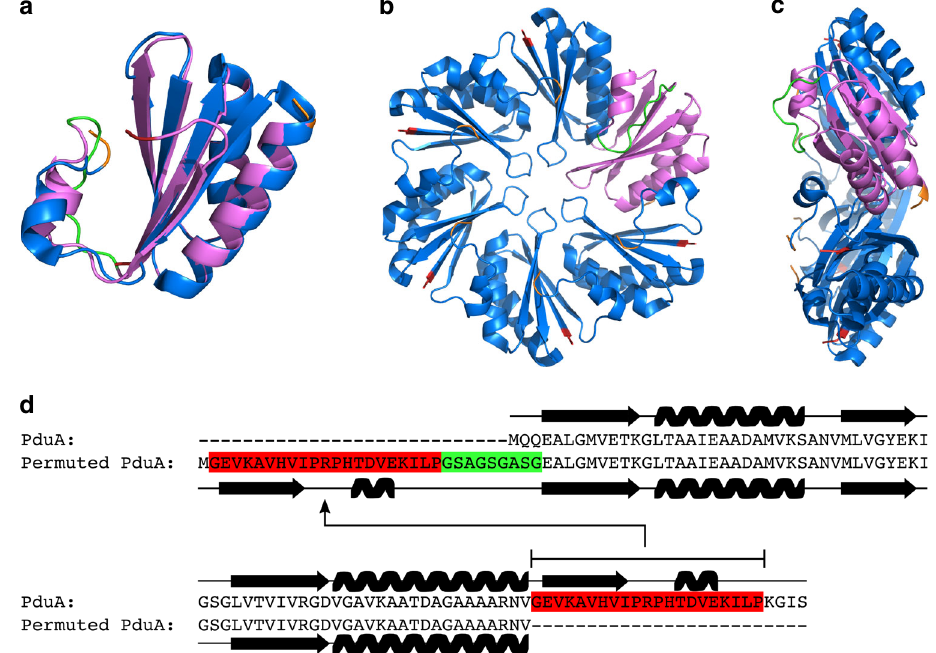
Fig. 4 Circular permutation of the shell protein PduA. a Computationally generated model of our permuted PduA (PduA P ) generated with Phyre2 45 (magenta) overlaid with the native structure (blue) with the fl exible linker joining the native N- and C- termini highlighted in green. b , c Architecture of the native PduA hexamer 3NGK [http://dx.doi.org/10.2210/pdb3ngk/pdb] (blue) illustrating the permuted variant PduA P (magenta). N - and C - termini are highlighted in red and orange respectively in ( a , b ) and c . d Methodology for creating a circularly permuted PduA with the transplanted region highlighted in red and the linker region in